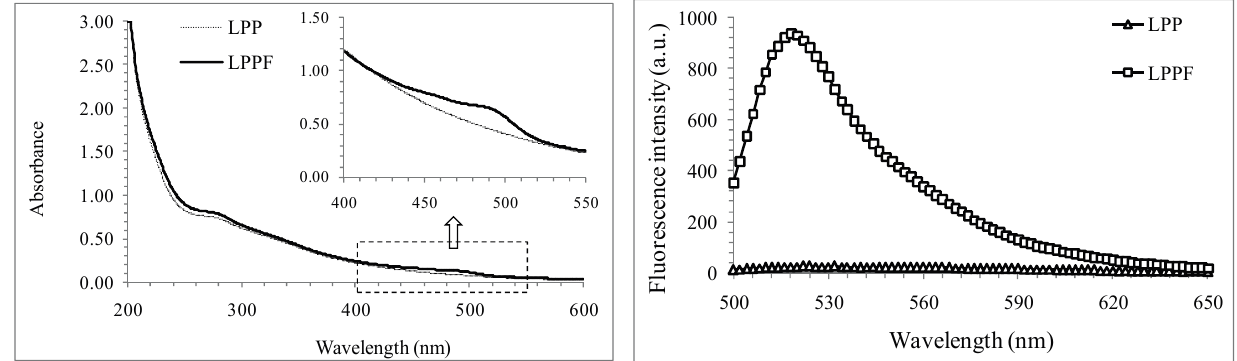
Figure 3. Ultraviolet-visible ( Left ) and fluorescence spectra ( Right ) of LPP and LPPF. The excitation wavelength for fluorescence scanning was 495